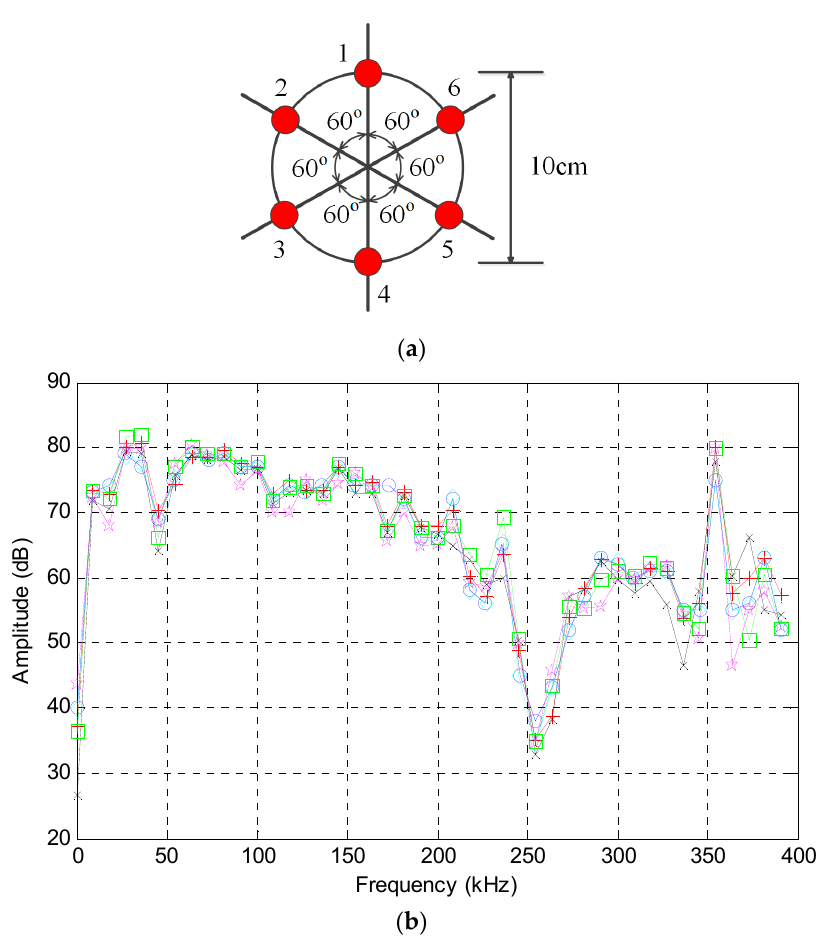
Figure 4. Sensor arrangement and the frequency response. ( a ) Sensor arrangement; and ( b ) frequency response of the AE sensor. Table 1. Technical specifications of the AE sensor.